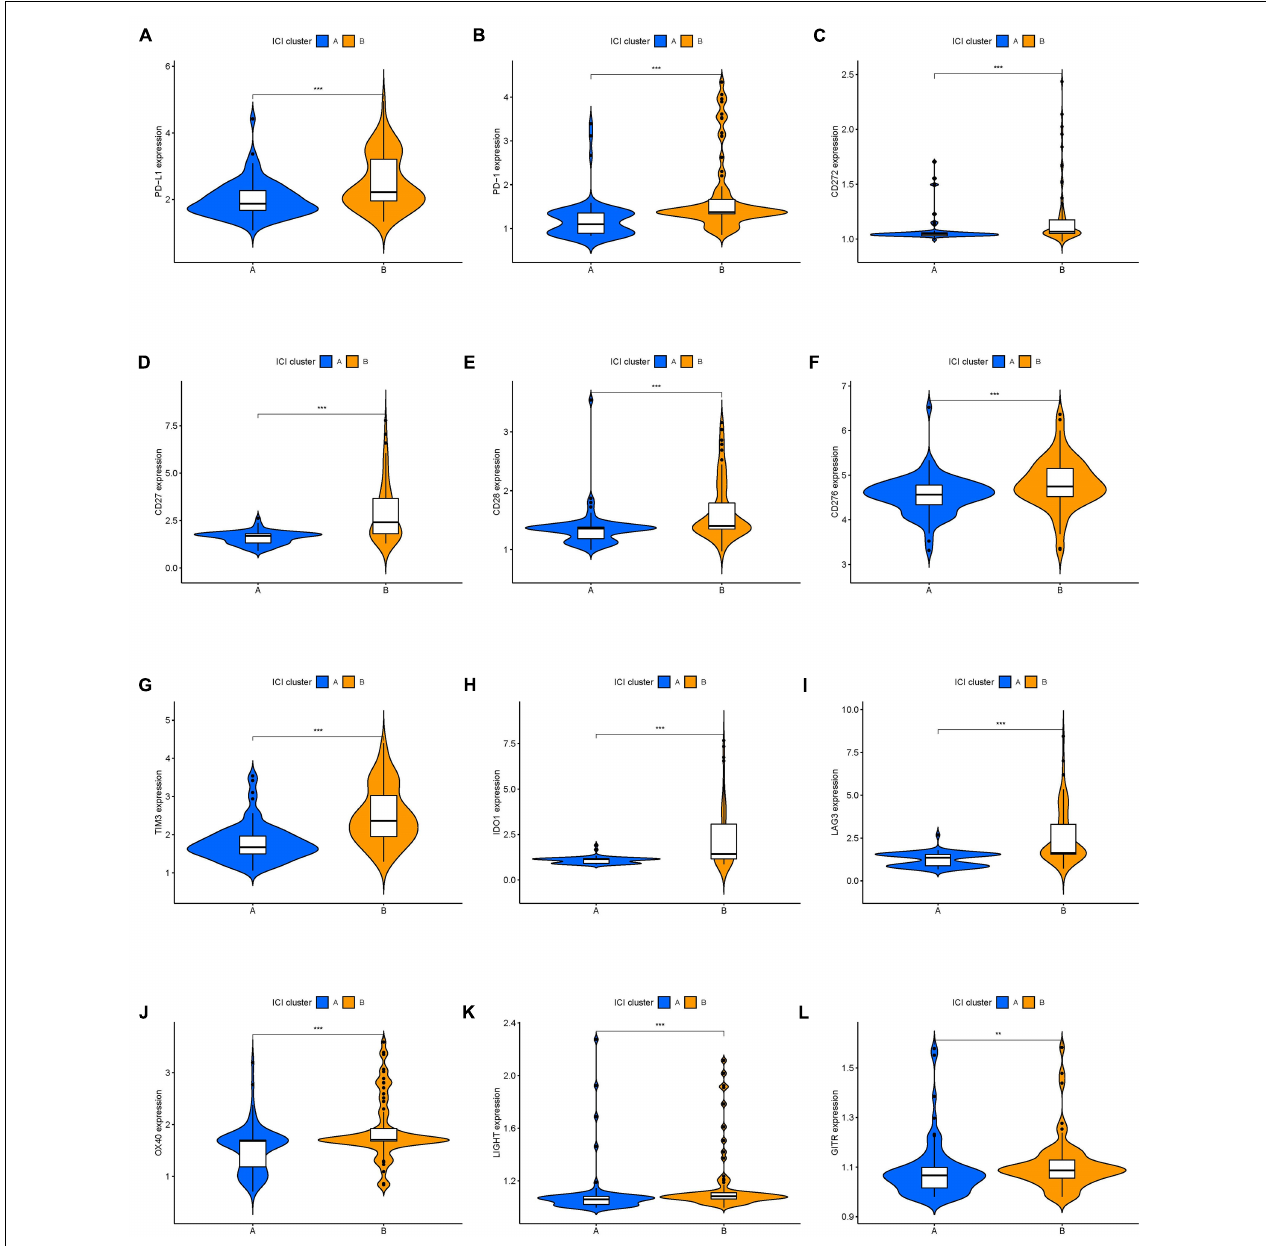
FIGURE 3 | The expression levels of immune checkpoint-related genes in different ICI clusters of UVM. (A) PD-L1. (B) PD-1. (C) CD272. (D) CD27. (E) CD28. (F) CD276. (G) TIM3. (H) IDO1. (I) LAG3. (J) OX40. (K) LIGHT. (L) GITR. * p < 0.05; ** p < 0.01; and *** p < 0.001. UVM, uveal